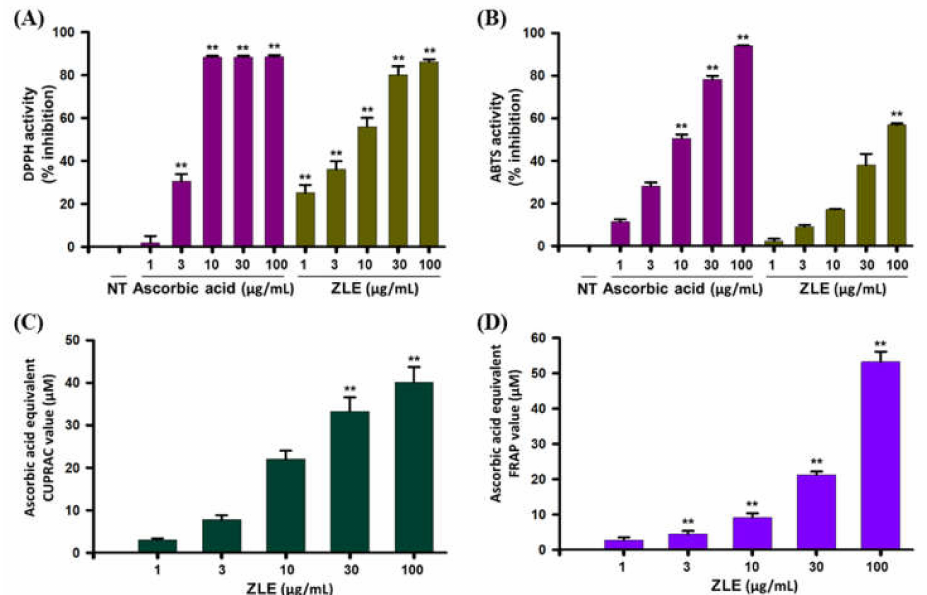
Figure 3. Antioxidant potential of ethanol extracts of M. zapota L. leaves (ZLE). ( A ) 2,2-Diphenyl-1- picrylhydrazyl radical (DPPH • ) scavenging, ( B ) 2,2 (cid:48) -Azino-bis(3-ethylbenzthiazoline-6-sulphonic acid radical cation (ABTS • +) scavenging, ( C ) Cupric-reducing antioxidant capacity (CUPRAC),